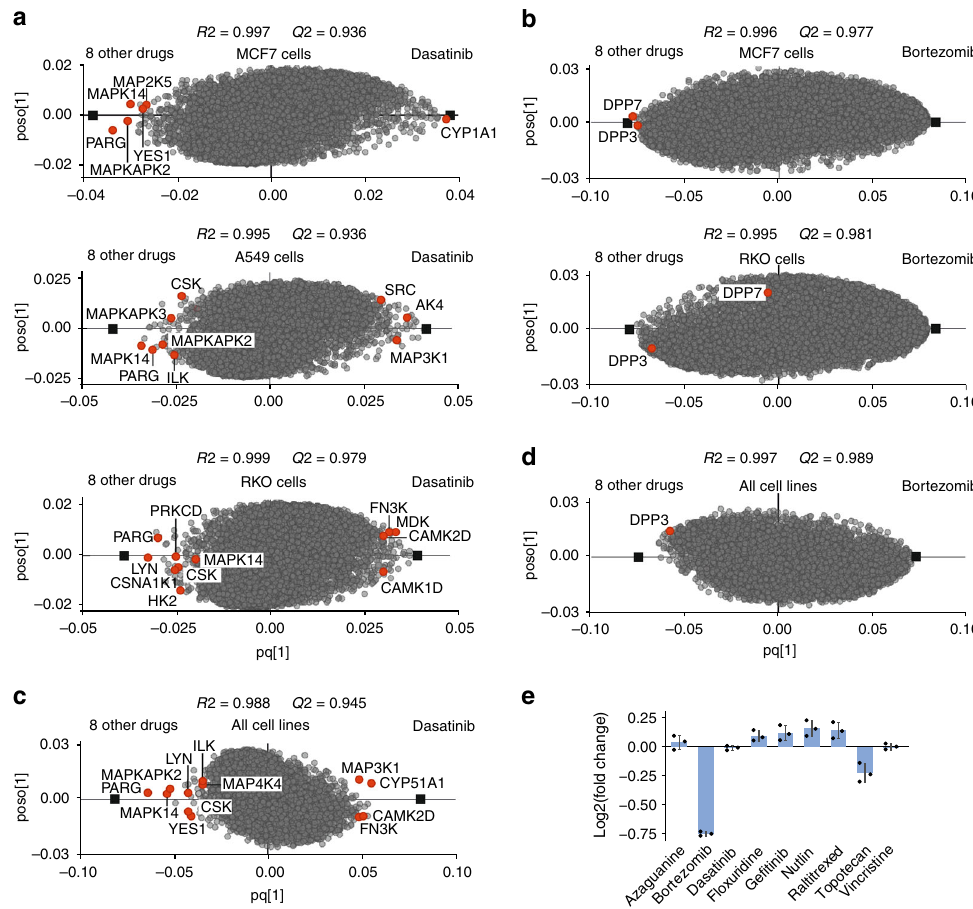
Fig. 6 Deeper ProTargetMiner dataset with 8 contrasting compounds is successful in target/MOA deconvolution. a OPLS-DA enabled deconvolution of multiple kinases as targets for dasatinib in three cell lines (drug targets shown in red circles). b deconvolution of DPP7 and DPP3 in MCF-7 and DPP3 in RKO cells. In A549 cells, these targets were not among the top 100 proteins. c identi fi cation of multiple targets for dasatinib in the merged dataset from three cell lines. d merging all cell lines shows that DPP3 is a common bortezomib target. Moreover, protein ubiquitination was the top GO term for 30 up- regulated proteins for bortezomib (11/30 proteins, p < 2E-06) in the merged dataset. e the speci fi c down-regulation of DPP3 in response to bortezomib in MCF-7 cells. Data are represented as mean ± s.d. ( n = 3 biologically independent experiments). Supplementary Data 4 – 7 were used for making panels a – e . Source data are provided as a Source Data fi